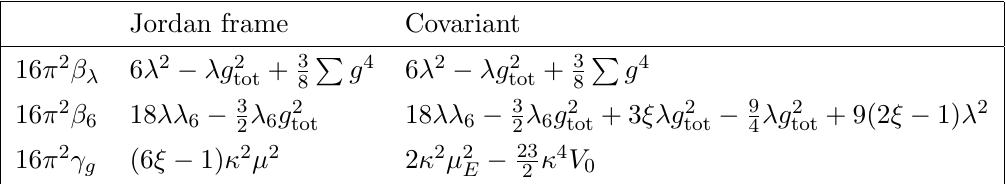
= (cid:22) 2 + 4 (cid:20) 2 V 0 (cid:24) E